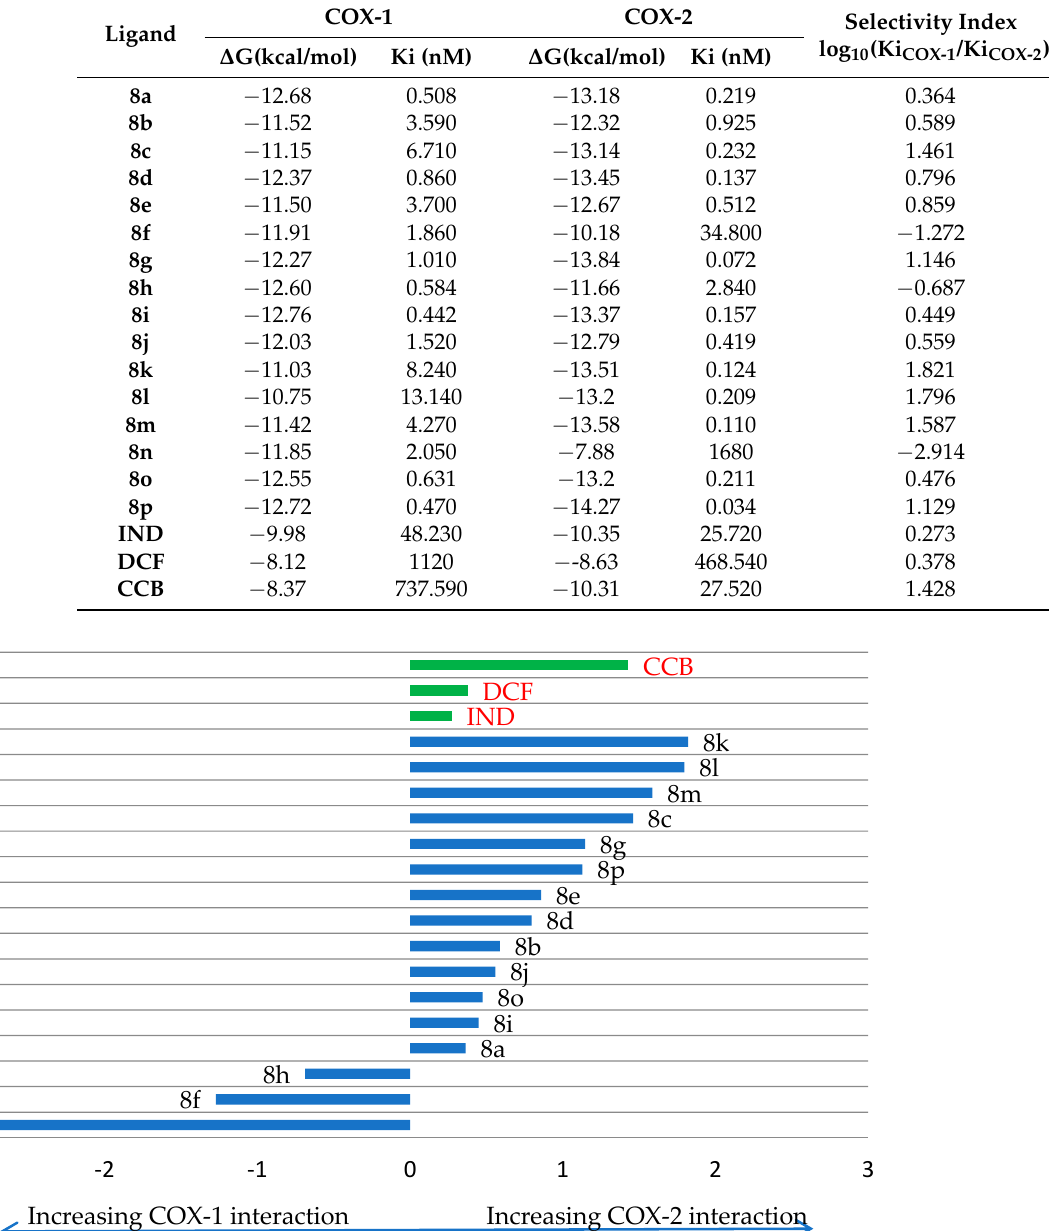
Figure 2. The COX interaction of NO-IND-OXDs 8a–p in respect to reference drugs.